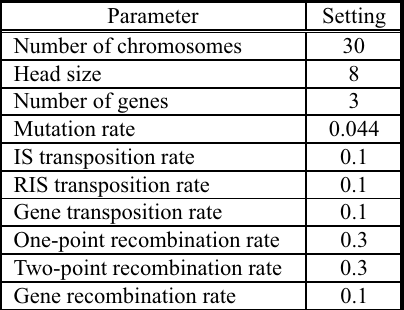
Table 5. Settings of major parameters in GEP.